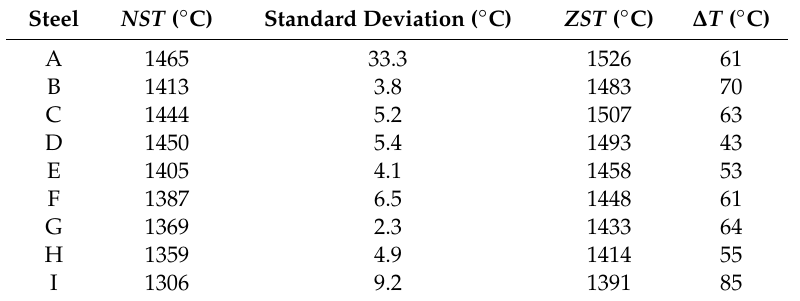
Table 2. Determined nil-strength and zero strength temperatures of the investigated steels.